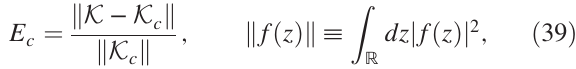
R 2 . An example system of a planar interface is explored (see Sec. IV for more R dz j f ð z Þj